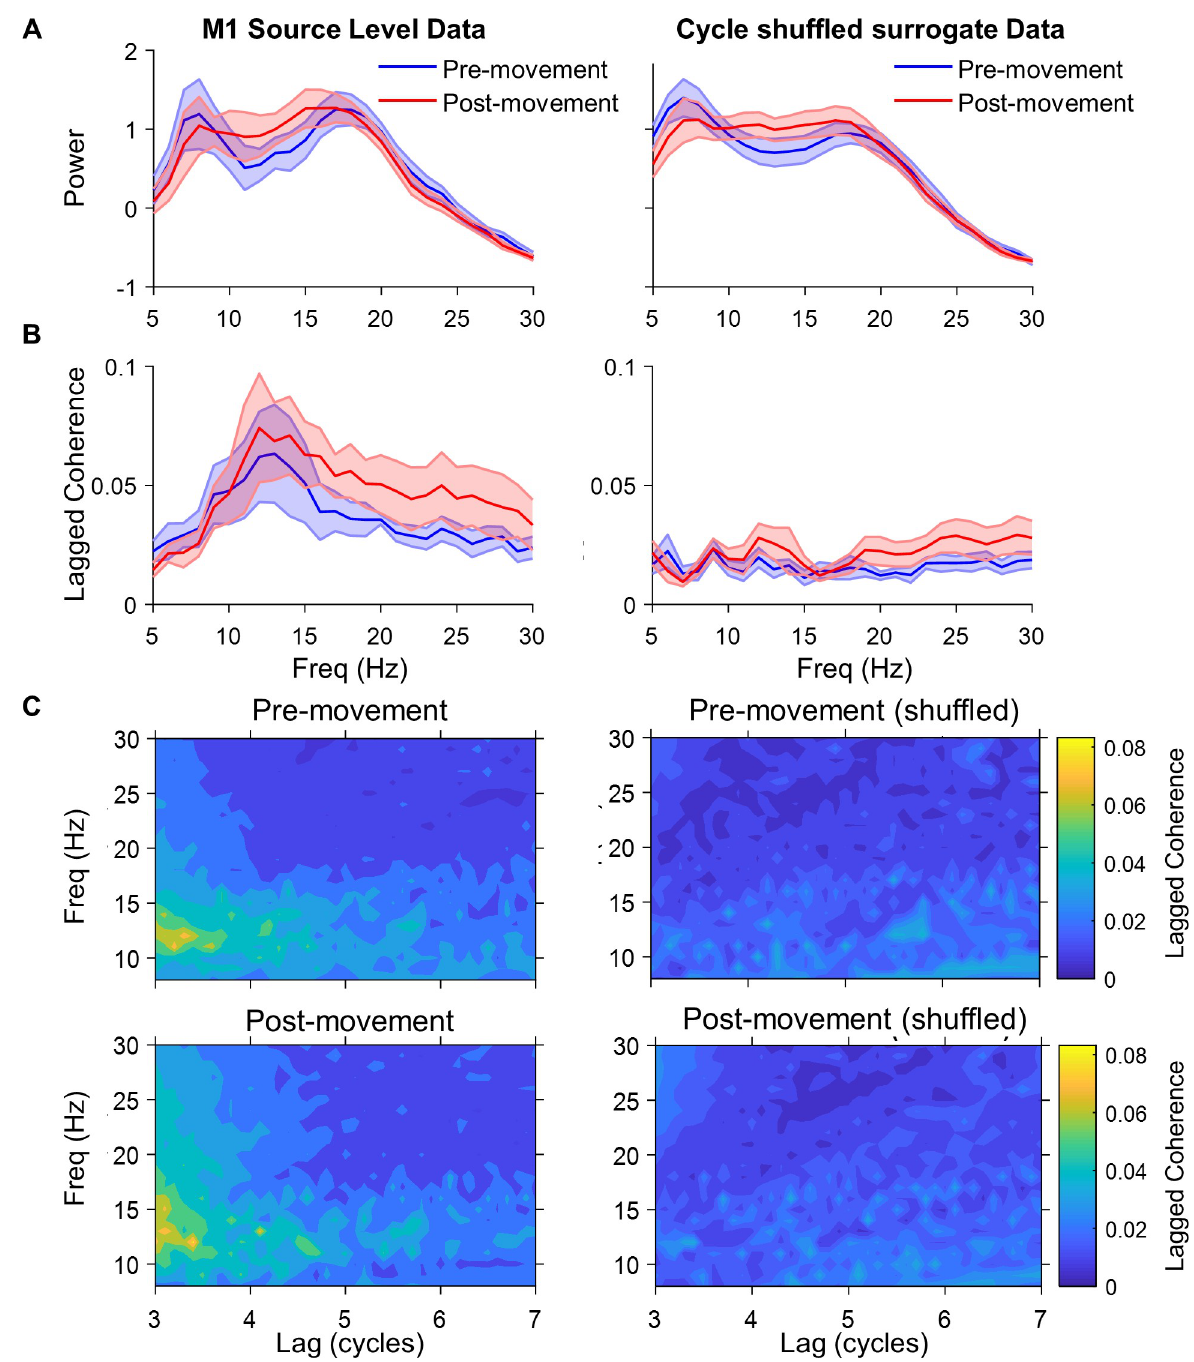
Fig 4. Motor cortical phase lagged coherence. (A) Mean PSD for all subjects ( ± SEM) for a virtual electrode from M1 (hand knob), response- locked data, with 1/f noise component removed (5–30 Hz). The power profile is preserved in the surrogate, cycle-shuffled data (right panel). Data shown both pre- and post- movement. (B) Lagged coherence (3 cycles) for real data (left) and cycle-shuffled surrogate control data (right). Note the absence of a strong peak in lagged coherence at the beta power peak of 18 Hz. (C) Lagged coherence for beta activity (13–30 Hz) rapidly falls off further after 3 cycles, compatible with burst activity (here shown for both pre-movement [top] and post-movement [bottom]). The underlying data can be found at https://osf.io/eu6nx/. PSD, power spectral density.